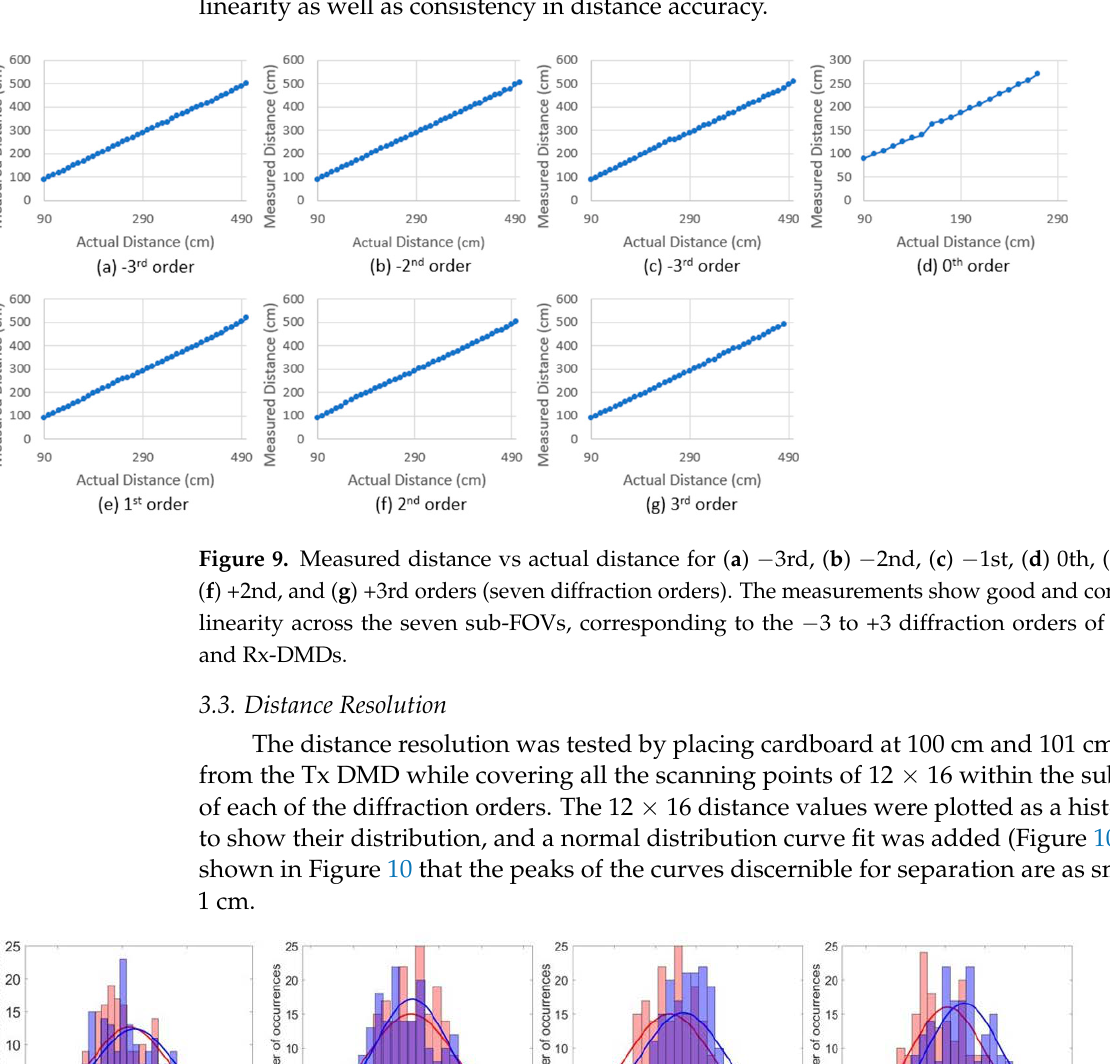
Figure 10. Histogram of distance values for ( a ) − 3rd, ( b ) − 2nd, ( c ) − 1st, ( d ) 0th, ( e ) +1st, ( f ) +2nd, and ( g ) +3rd orders. Across the 7 sub-FOVs, the distance accuracy was at least 1 cm.